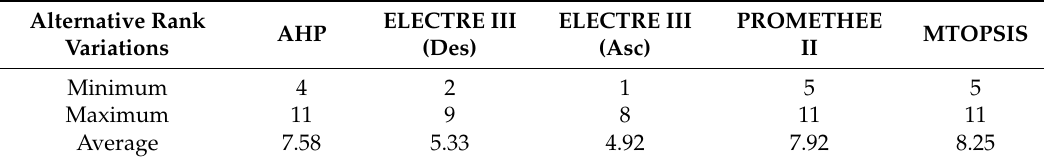
Table 15. Rank variation results for weight sensitivity